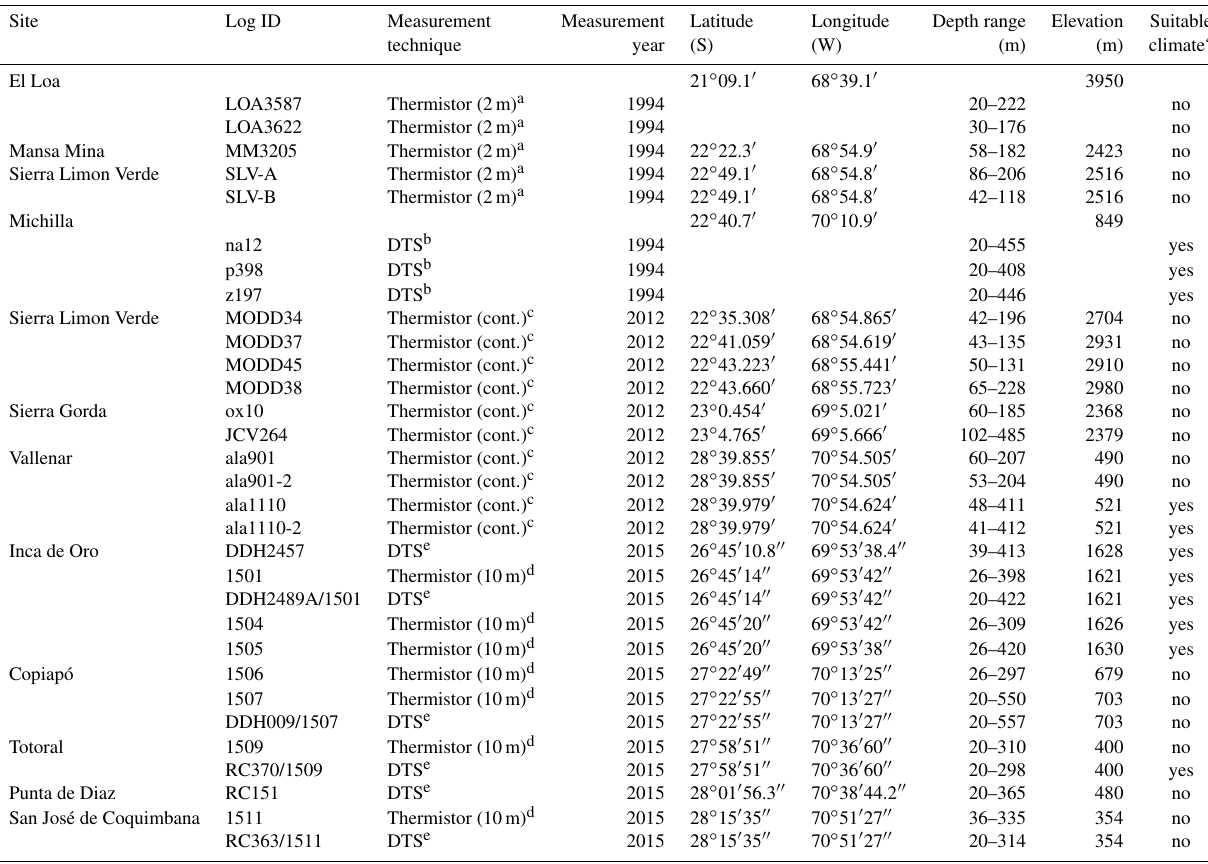
Table 1. Location and technical information concerning the borehole temperature–depth profiles measured in 1994 by Springer (1997) and Springer and Förster (1998), in 2012 by Gurza Fausto (2014) and in 2015, where the column “suitable climate?” indicates if it passed the selection criteria outlined in Sect. 3.